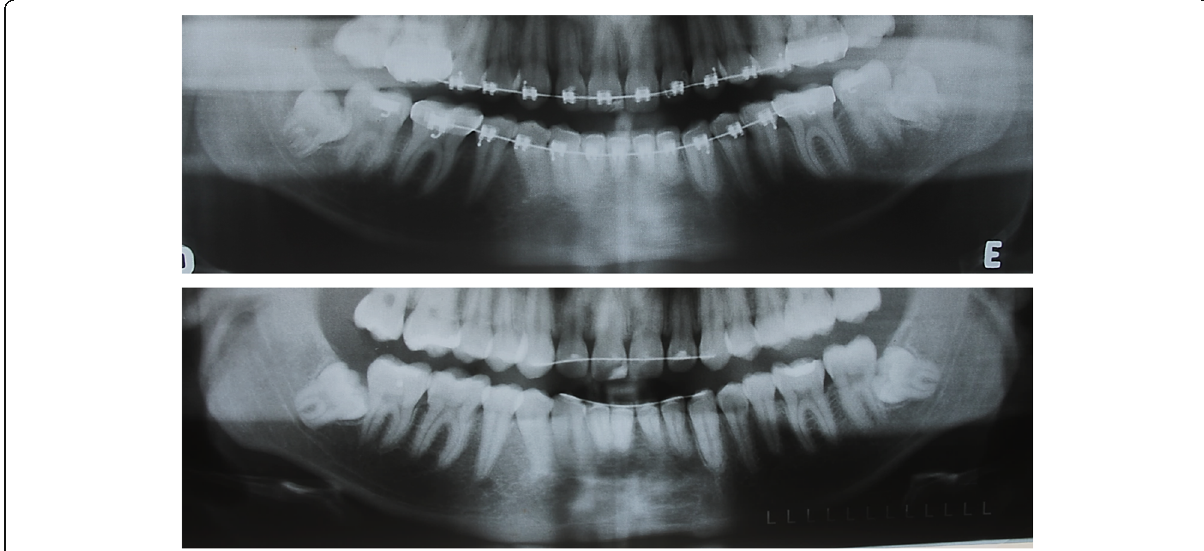
Fig. 2 Panoramic radiograph at the end of orthodontic treatment (XR1) of patient # 17 (impacted group) at 16 years and 0 months of age ( A ) and at 20 years and 1 month in XR2 ( B